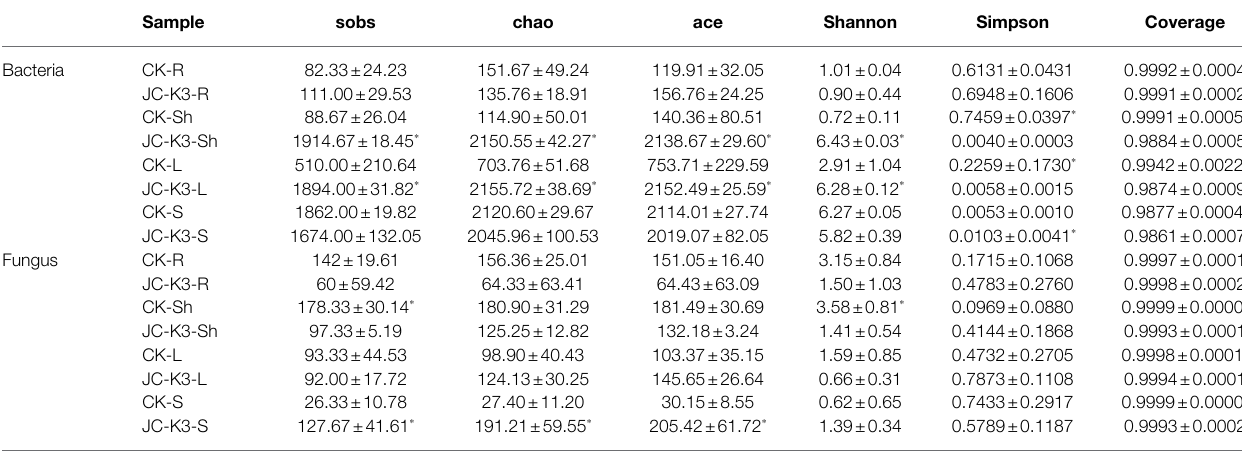
TABLE 2 | Diversity and richness indices of wheat root (R), shoot (Sh), leaf (L), and rhizospheric soil (S) samples under different treatments. Sample